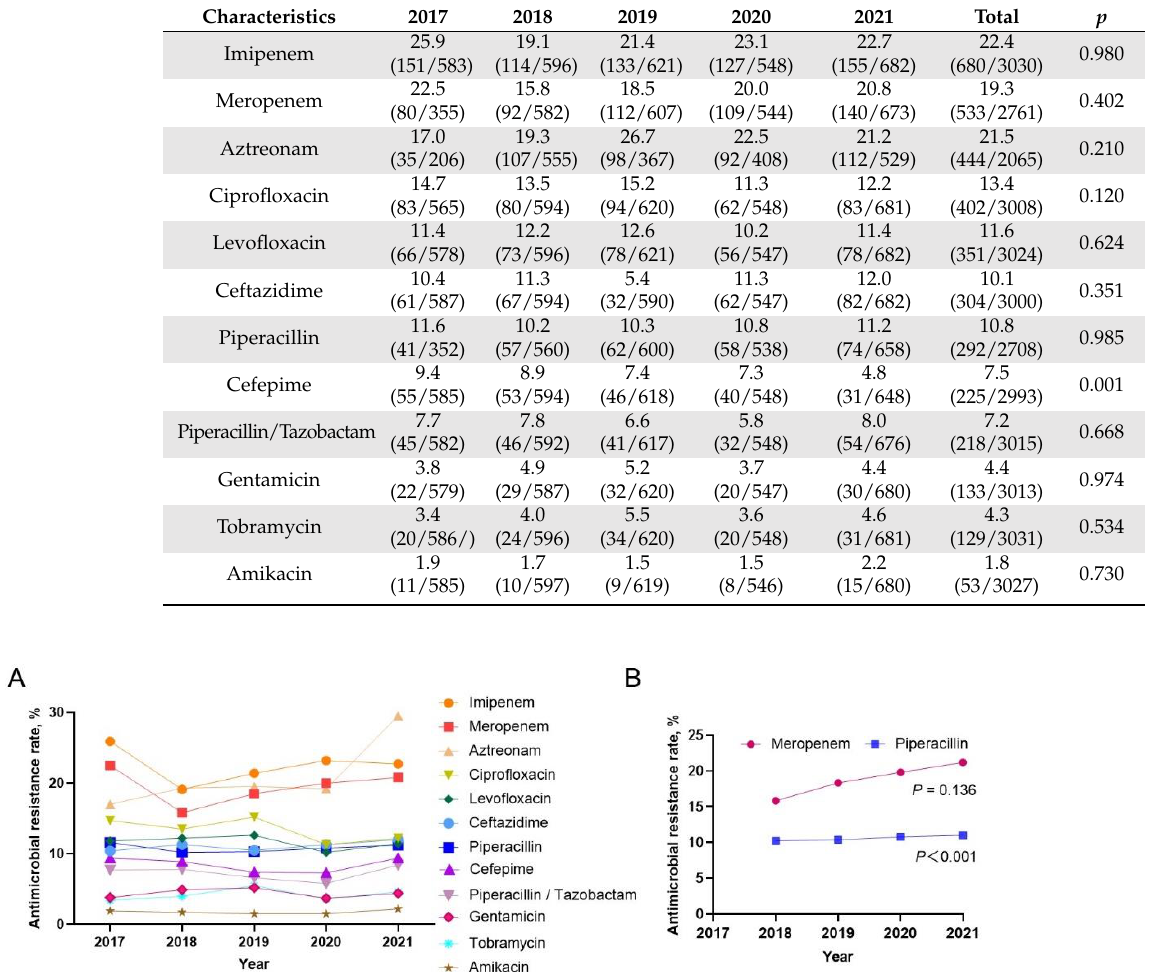
Table 1. Resistance rate of P. aeruginosa to antibiotics in 2017–2021 (%).